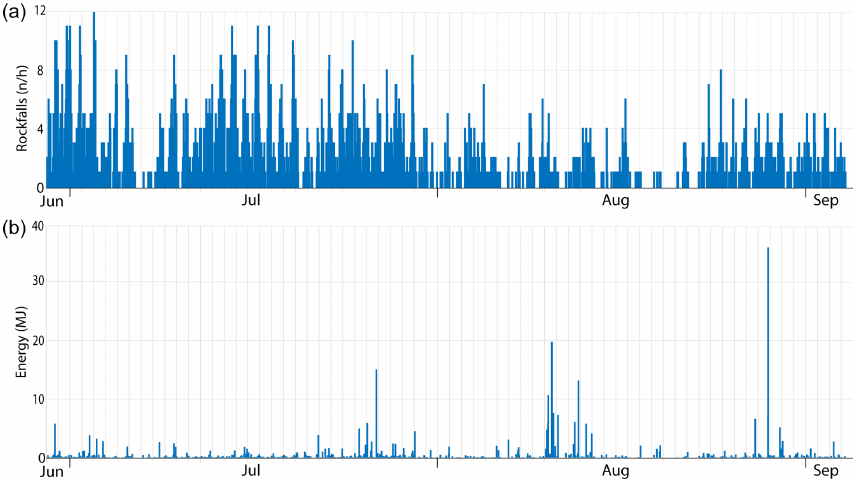
Figure 4. Seismic records in 2019. (a) Number of rockfalls per hour. (b) Maximum energy (MJ) of each rockfall.